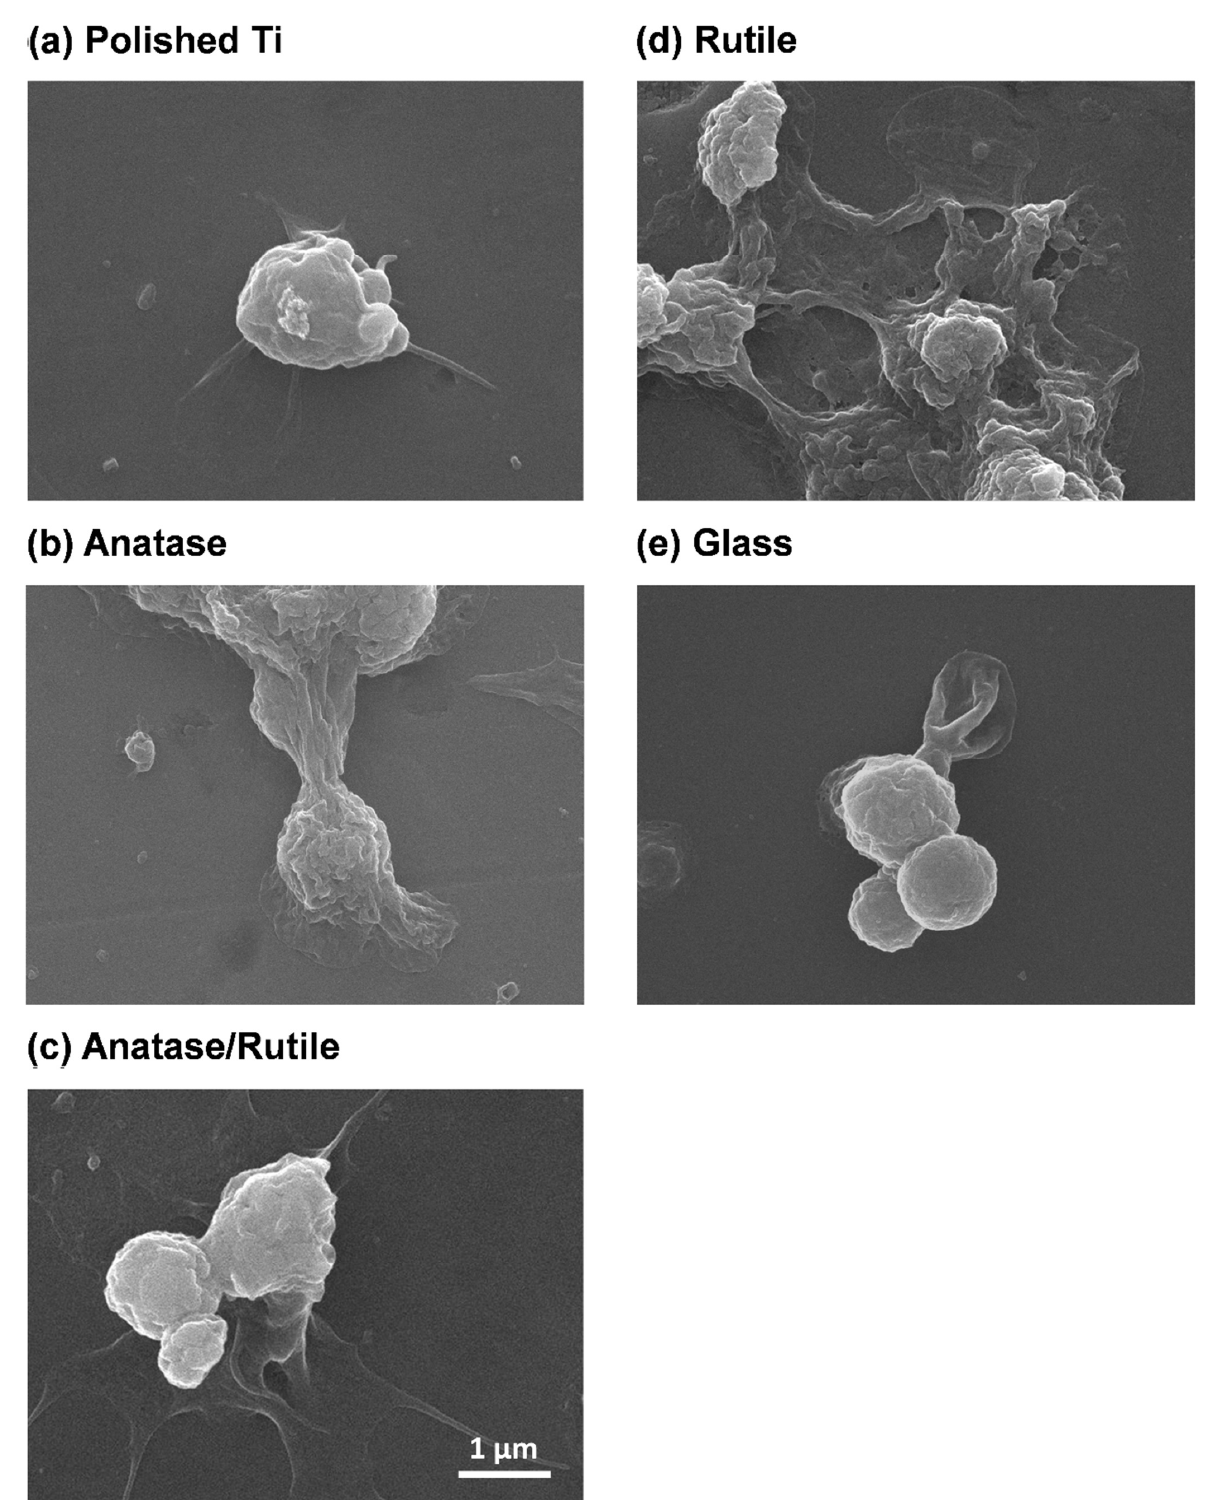
Figure 8. SEM images of platelet adhesion on the surface of test specimens after 10 min. Platelet adhesion was more pronounced on treated Ti surfaces than on untreated one; the aggregation of platelets as well as the stretching and flattening of pseudopods were more significant on rutile phase